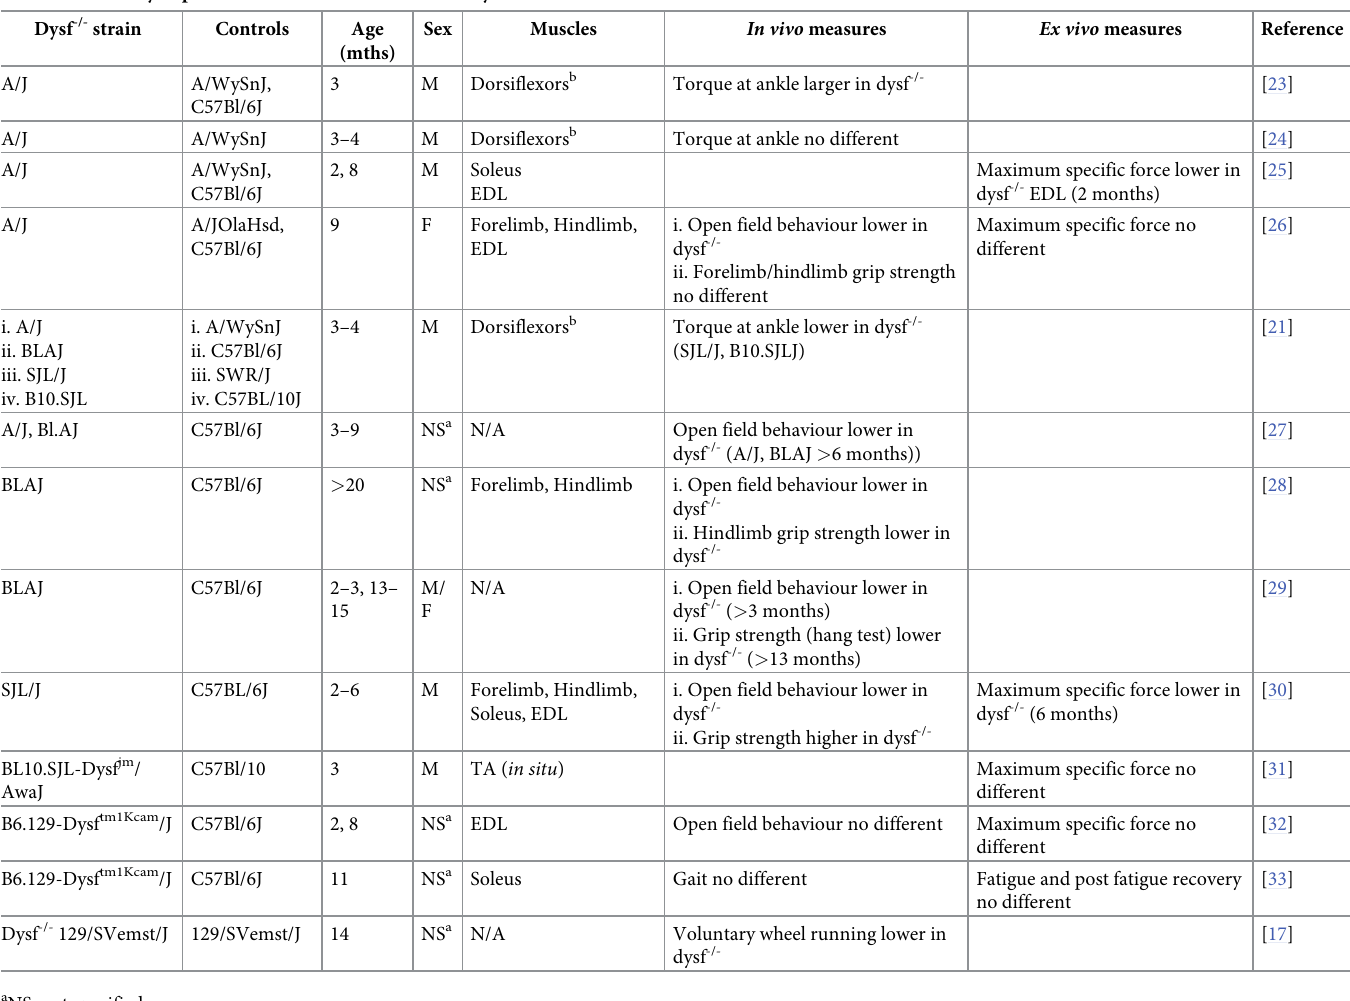
Table 1. Summary of prior studies of muscle function in dysferlin-deficient